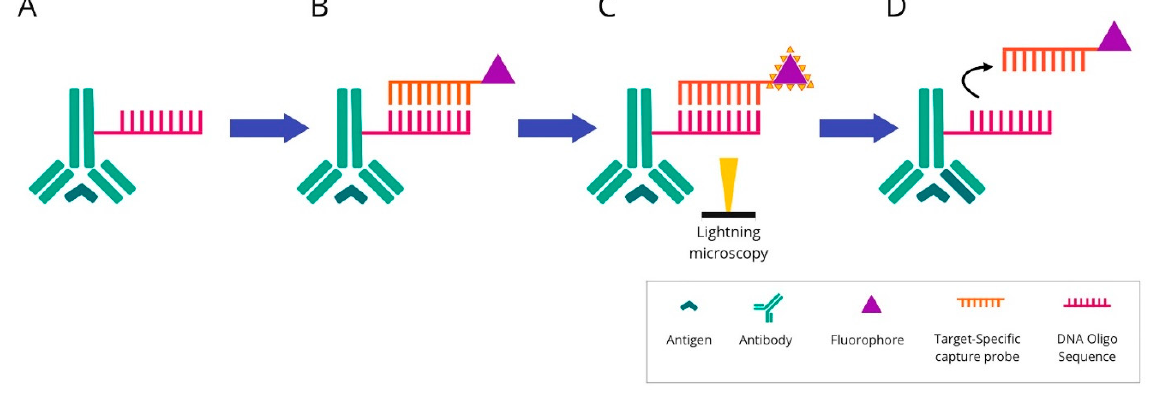
Figure 6. Overview of COdetection by indEXing technique: ( A ) Mixture of target antibodies conjugated with unique oligonucleotide barcodes are used simultaneously to stain a tissue section. ( B ) Then, fluorescently labelled complementary oligonucleotides are added. ( C ) The visualisation is conducted via light microscopy. The targets are detected and imaged in cycles of three targets in each cycle. ( D ) After imaging, the reporter oligonucleotides are stripped using a stripping buffer. The cycle is repeated until all antibodies within the panel have been revealed and visualised.